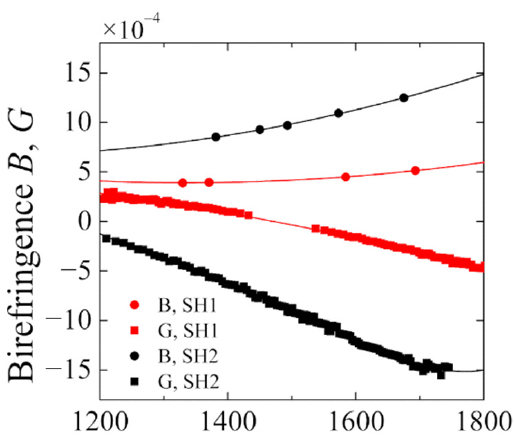
Figure 2. Measured phase B and group G birefringence of the side-hole fibers.